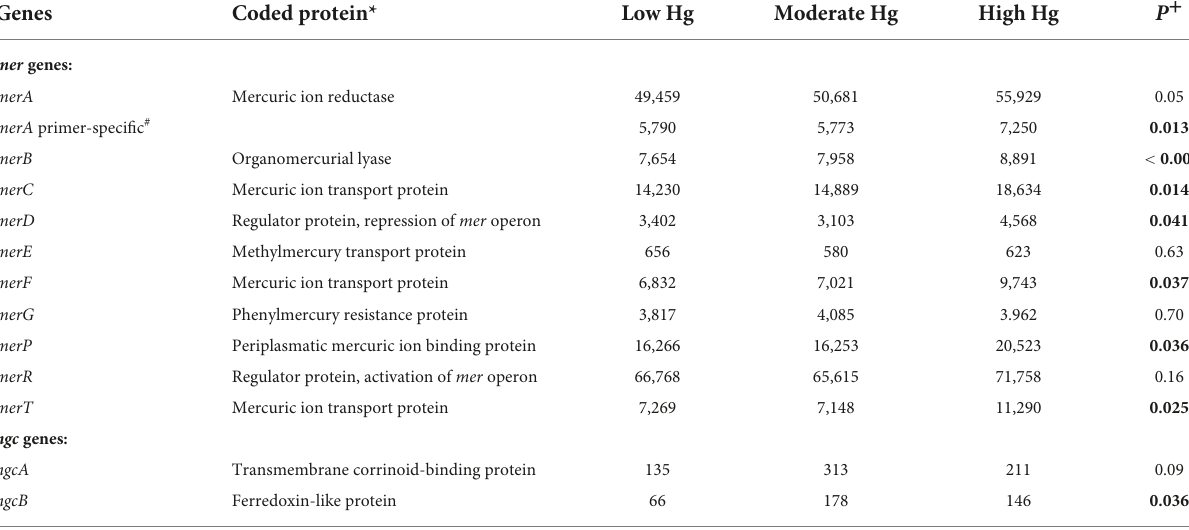
TABLE 7 Normalized counts of mer and hgc genes of soils with the three different Hg contamination levels (n = 3). Genes Coded protein* Low Hg